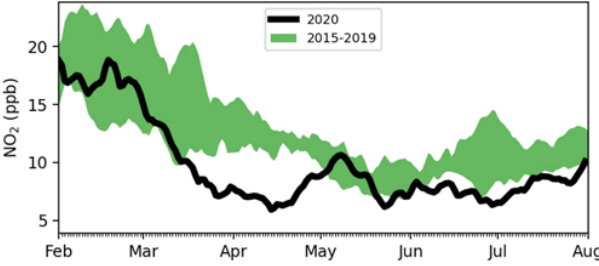
Figure 3. SoCAB pollutant concentrations for 2020 (black line) and for 2015–2019 (green shading). Data are averaged over 21 sites that contain data throughout the time